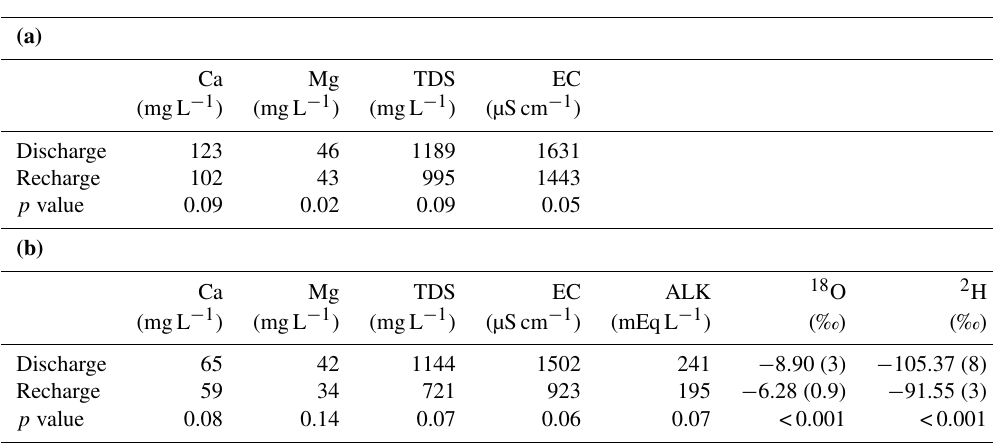
Table 1. Average concentration of chemical tracers in hydrologically simulated discharge and recharge areas, as well as p values of the nonparametric Wilcoxon rank sum test (equality of median) used to assess the differences between simulated groundwater discharge and recharge areas. p values less than 0.10 depict a statistically significant deference between chemistry of simulated groundwater discharge and recharge areas. (a) Concentration of chemical tracers in hydrologically simulated groundwater discharge and recharge areas; (b) concentration of chemical and isotopic tracers in hydrologically simulated discharge and recharge wetlands. The reported values in the parenthesis for 18 O (and 2 H) are the relative difference between average isotopic concentrations (ratio) in simulated discharge or recharge wetlands from average watershed concentration.